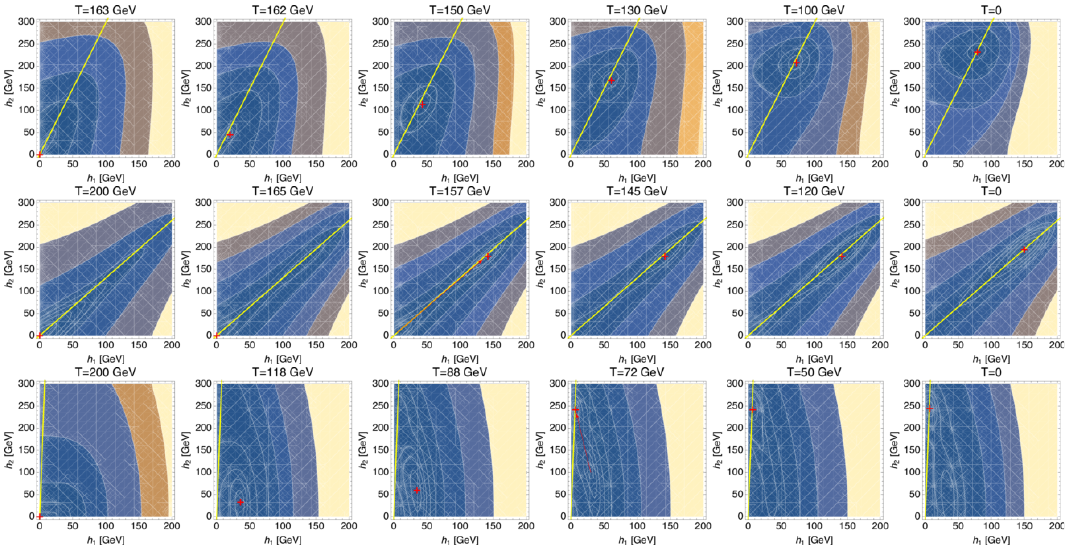
Figure 5 . Temperature evolution of the Higgs potential on the ( h 1 ; h 2 ) plane. As temperature cools down, the EW vacuum shifts away from the 0-vacuum. Depending on the way in which the vacuum (marked by the red plus) develops, three types of phase transition presented are possible in the 2HDM: 1-stage second order (top panel), 1-stage (cid:12)rst order (middle panel) and 2-stage transition (bottom panel). Red arrows indicate a jump between two degenerate vacuum in the (cid:12)rst order phase transition while the vacuum transitions smoothly in the second phase